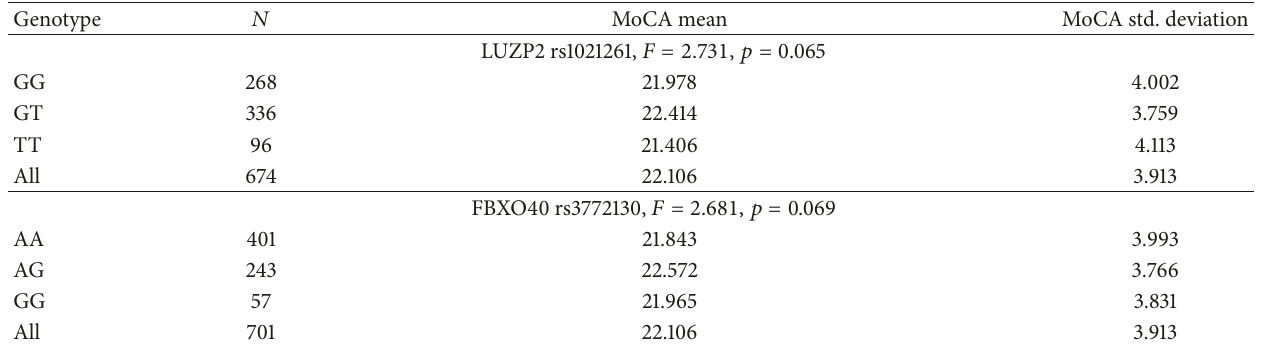
Table 3: One-way ANOVA analysis of MoCA scores among genotypes of genetic variants in LUZP2 and FBXO40 genes.